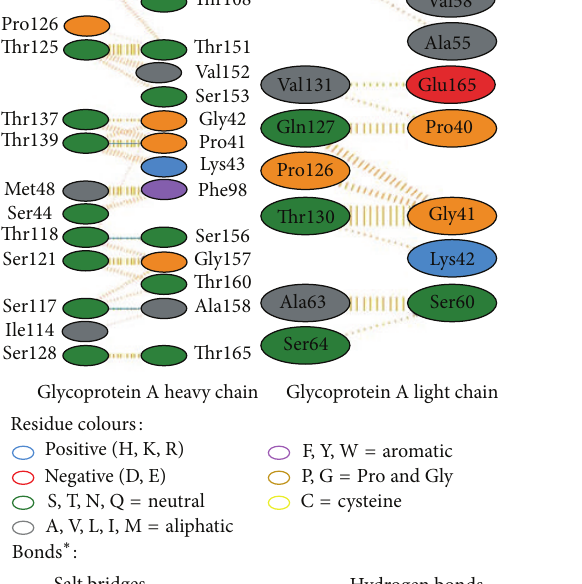
Figure 3: Interaction of glycoprotein A and motavizumab showing interaction of residues with heavy and light chain through various bonds ∗